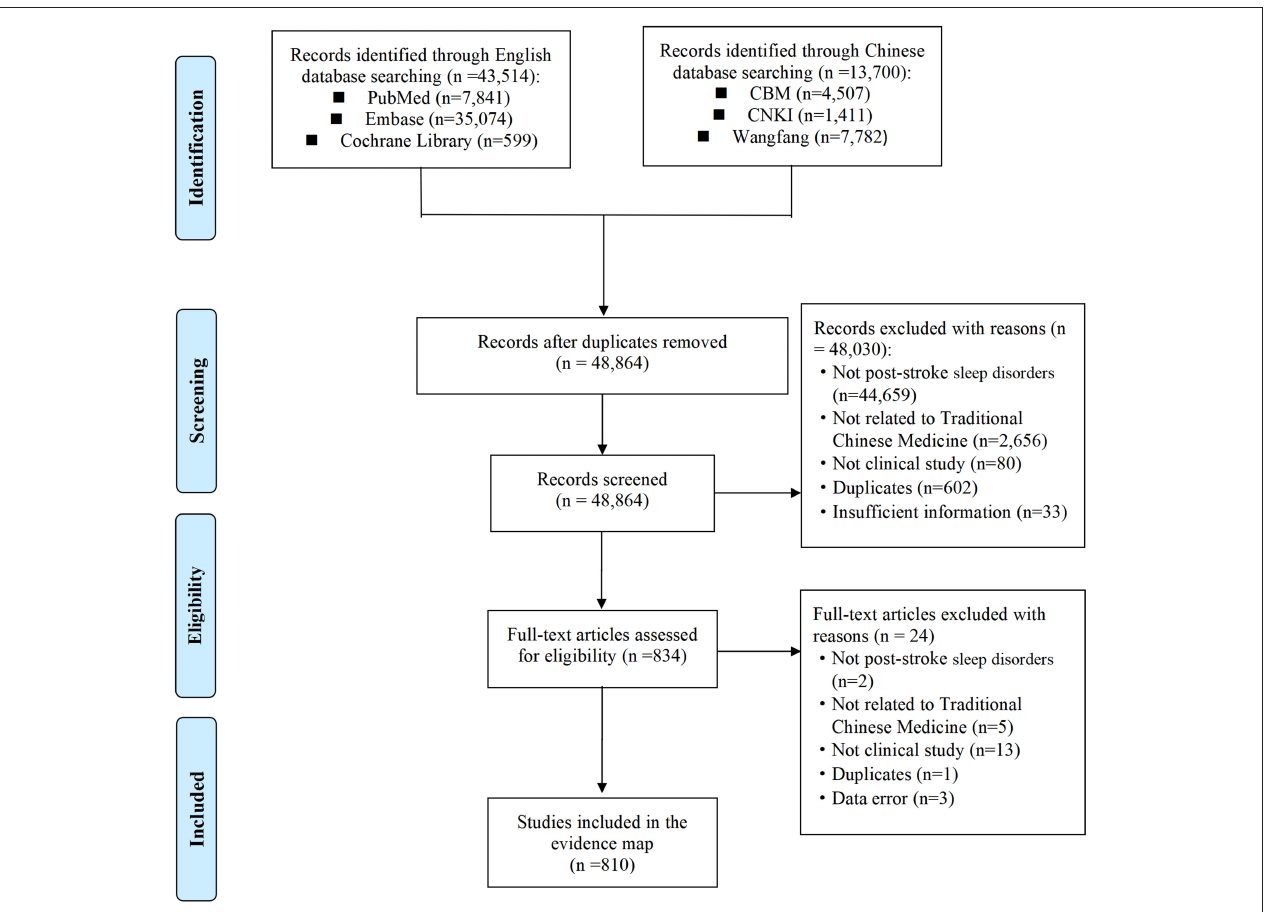
FIGURE 1 | Flowchart of study